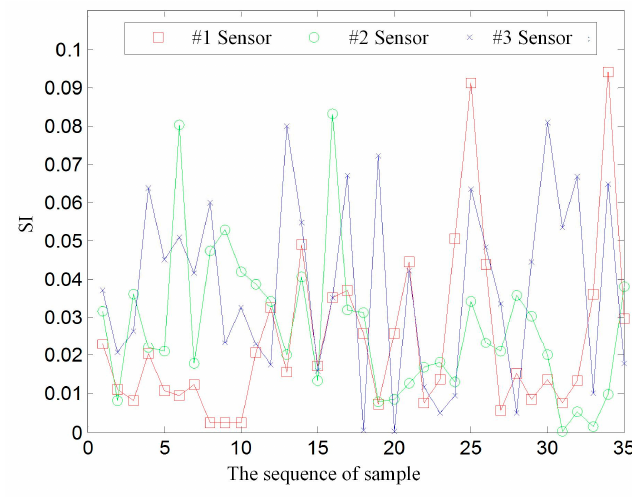
Figure 10. The SI of #1, #2, and #3 sensors of the healthy state.